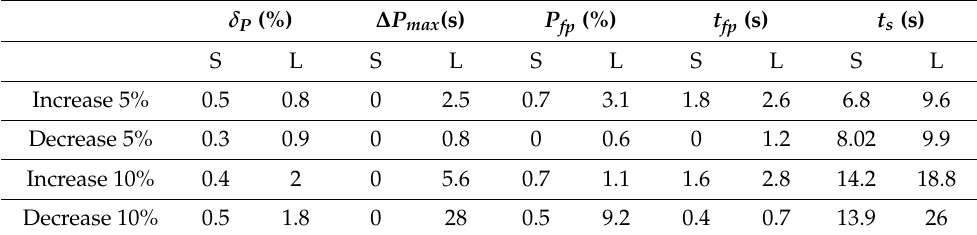
Table 2. Dynamic response index of power